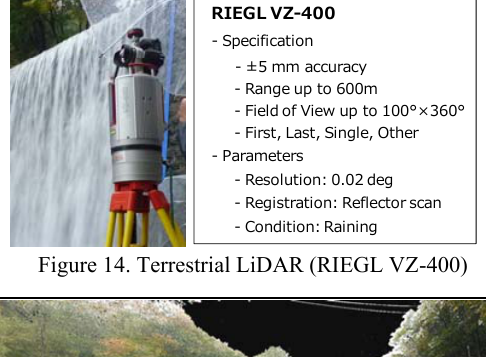
Figure 10. Panoramic video camera (THETA)